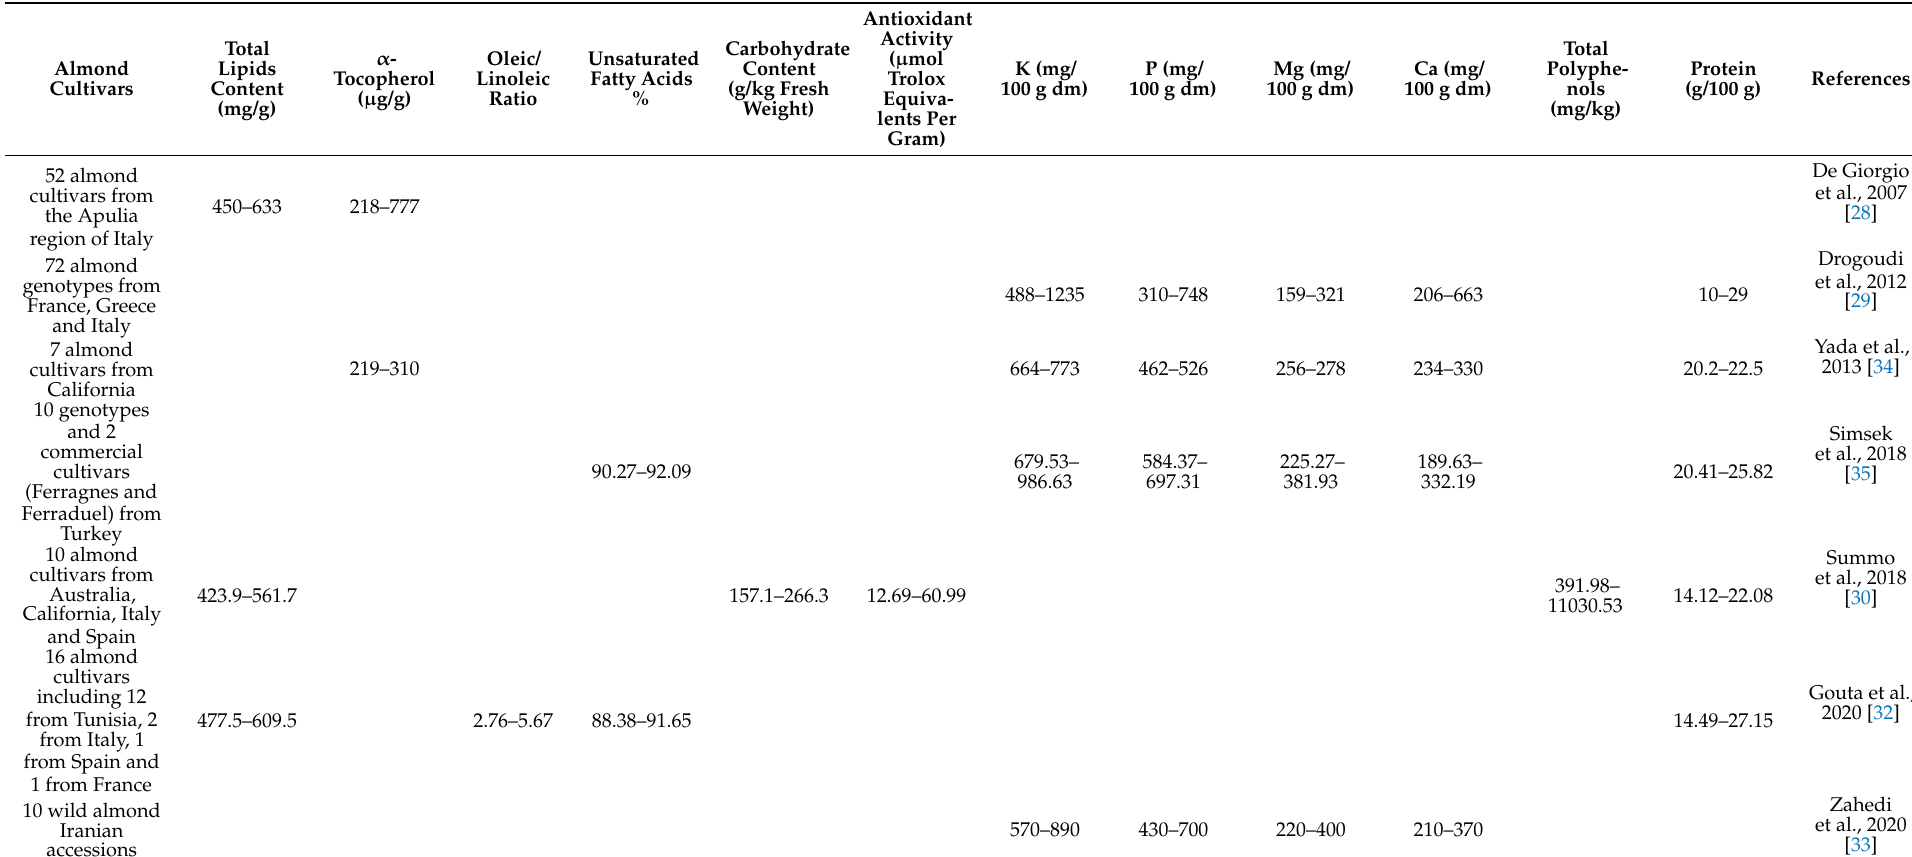
Table 1. Chemical composition and nutritional characteristics of